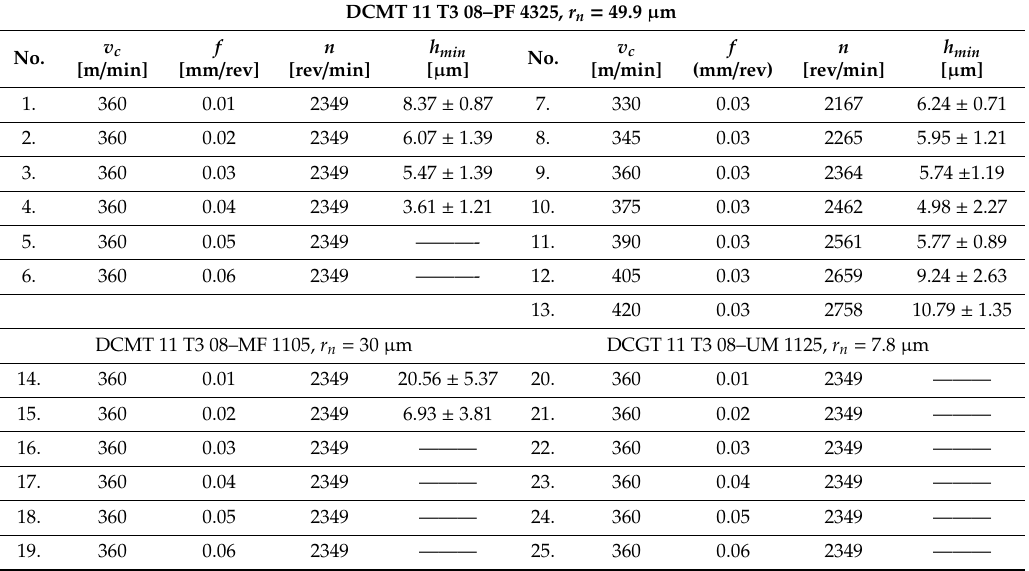
Table 2. Cutting conditions for the three insert types.